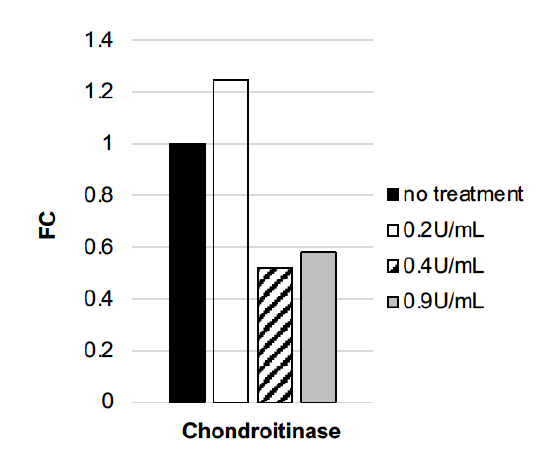
Figure 4. Chondroitinase impairs BAEC infection by E. ruminantium . Using 0.4 and 0.9U/mL chondroitinase resulted in a halving of the number of bacteria compared to the untreated condition. Bacterial quantification was performed at lysis stage by qPCR sol1 after chondroitinase treatment at three different concentration. Fold-change (FC) was obtained by calculating the bacterial amount differential for each condition compared to the condition without treatment and represented as 2 -ΔΔCt .